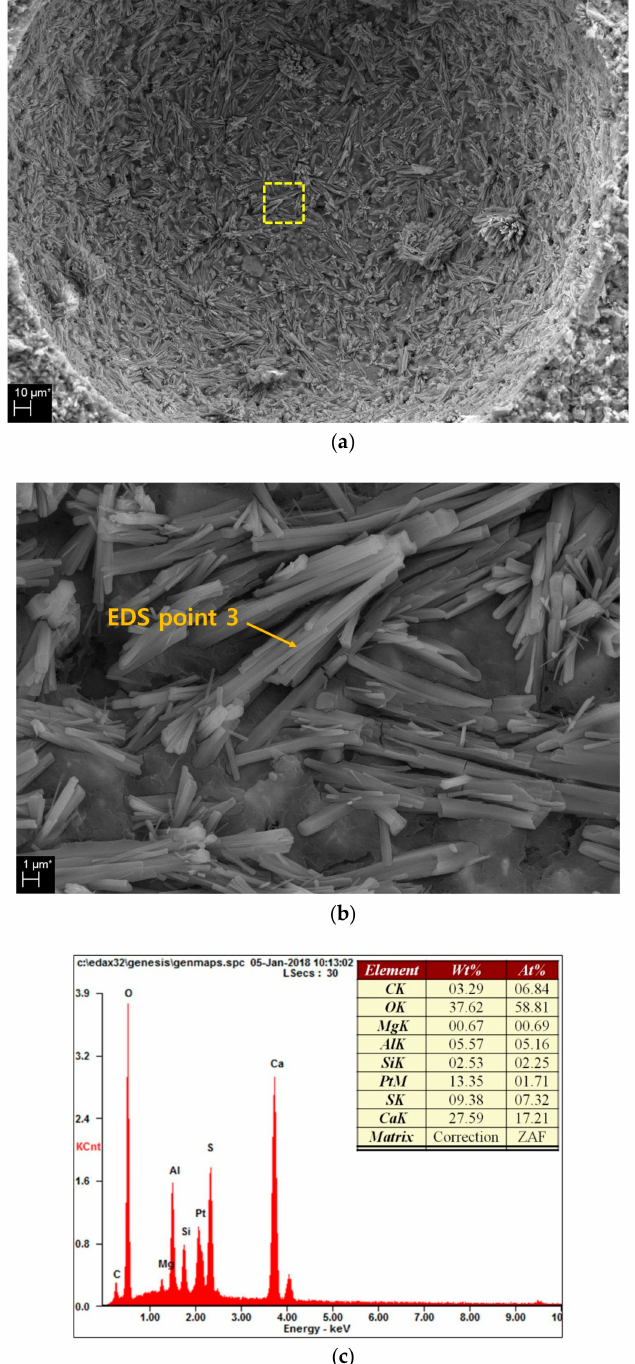
Figure 7. SEM in pore: ( a ) pore in 6% MS specimens, ( b ) magnification of hydration production, ( c ) EDS result of “EDS point